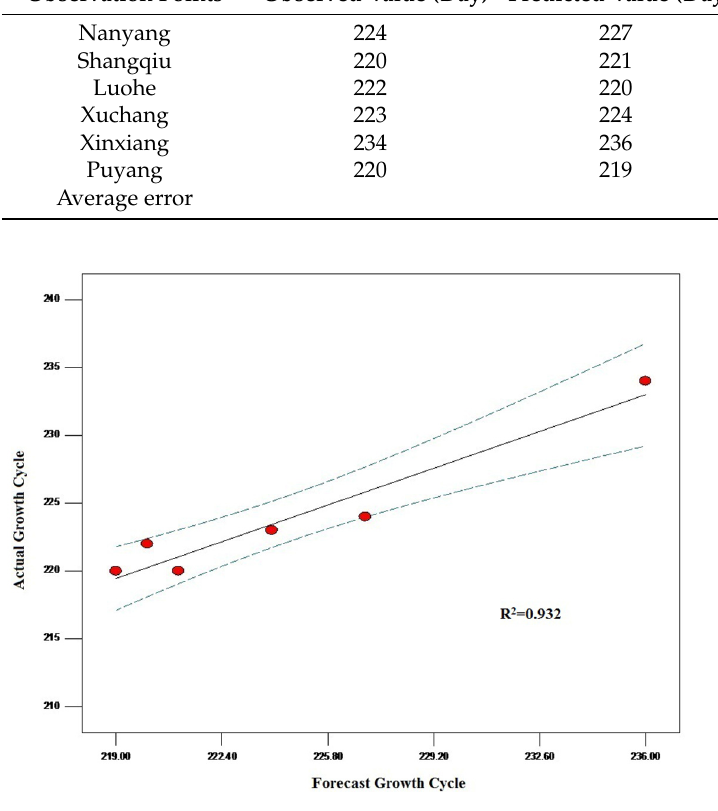
Figure 7. Scatter plot of forecasting the period of harvesting winter wheat in main producing areas of Henan province in 2020.